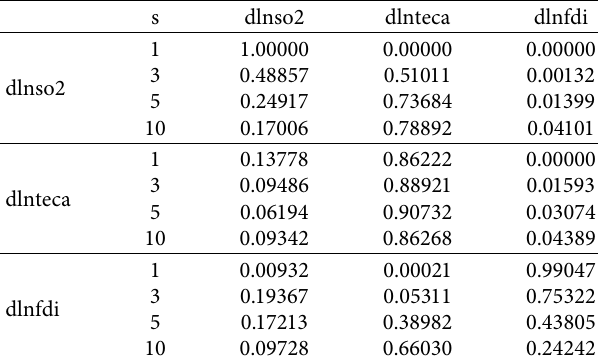
Table 7: The PVAR variance decomposition results of Model